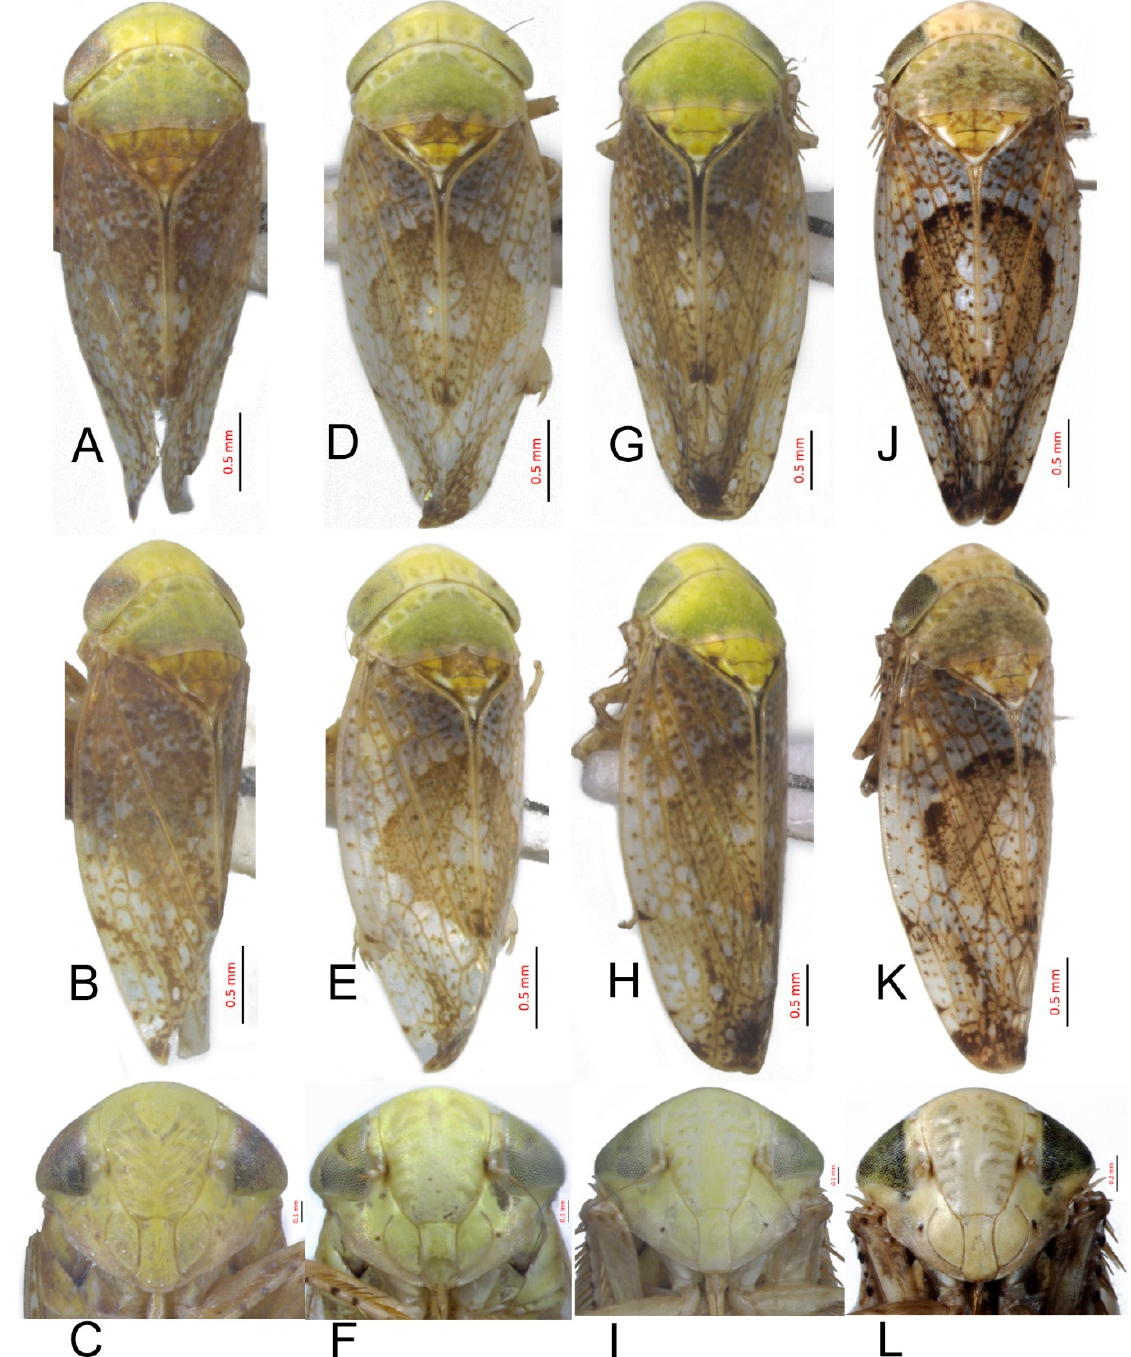
Figure 6. Species of Hishimonus . ( A – C ) H. concavus ; ( D – F ) H. dietrichi ; ( G – I ) H. bucephalus ; and ( J – L ) H. fletcheri . ( A , D , G , J ) Dorsal view; ( B , E , H , K ) latero-dorsal view; ( C , F , I , L ) Face.